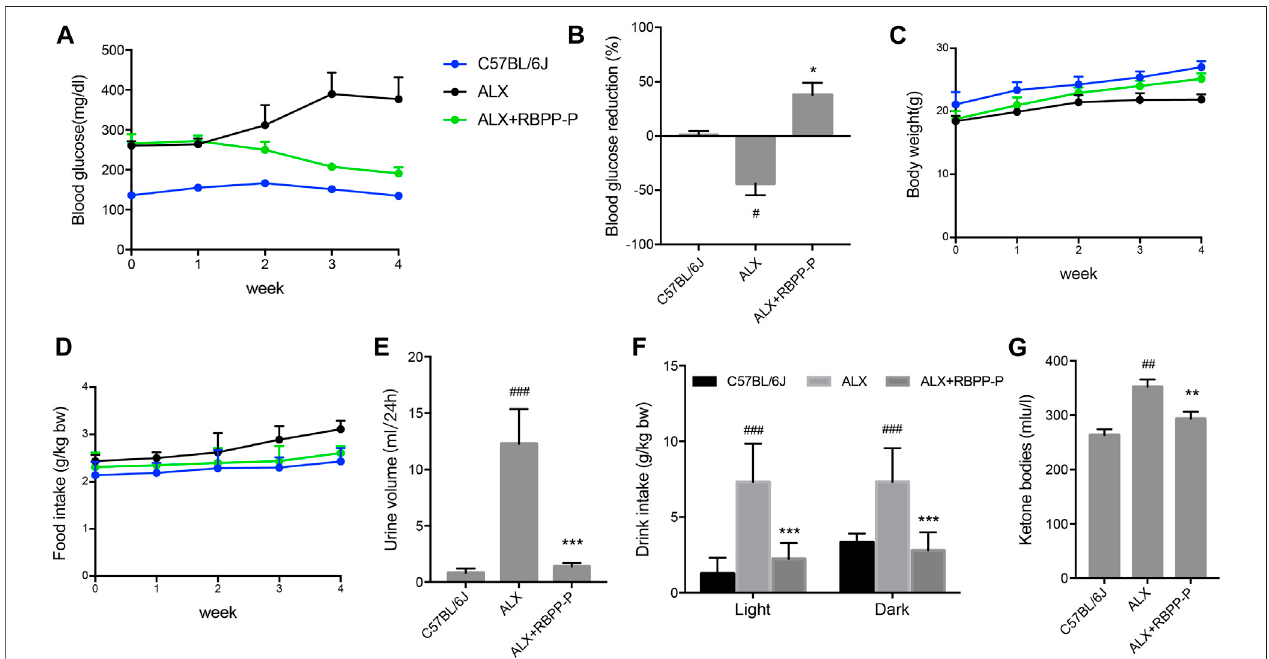
FIGURE 3 | Treatment with RBPP-P for 4 weeks improved hyperglycaemia and daily indicates in ALX mice ( n (cid:1) 10). Fasting blood glucose (A) and blood glucose reduction (B) were measured. (C) Body weight (D) Food intake. (E) Urine volume (F) Water intake (G) Serum ketone bodies. All data are expressed as mean ± s. d. # p